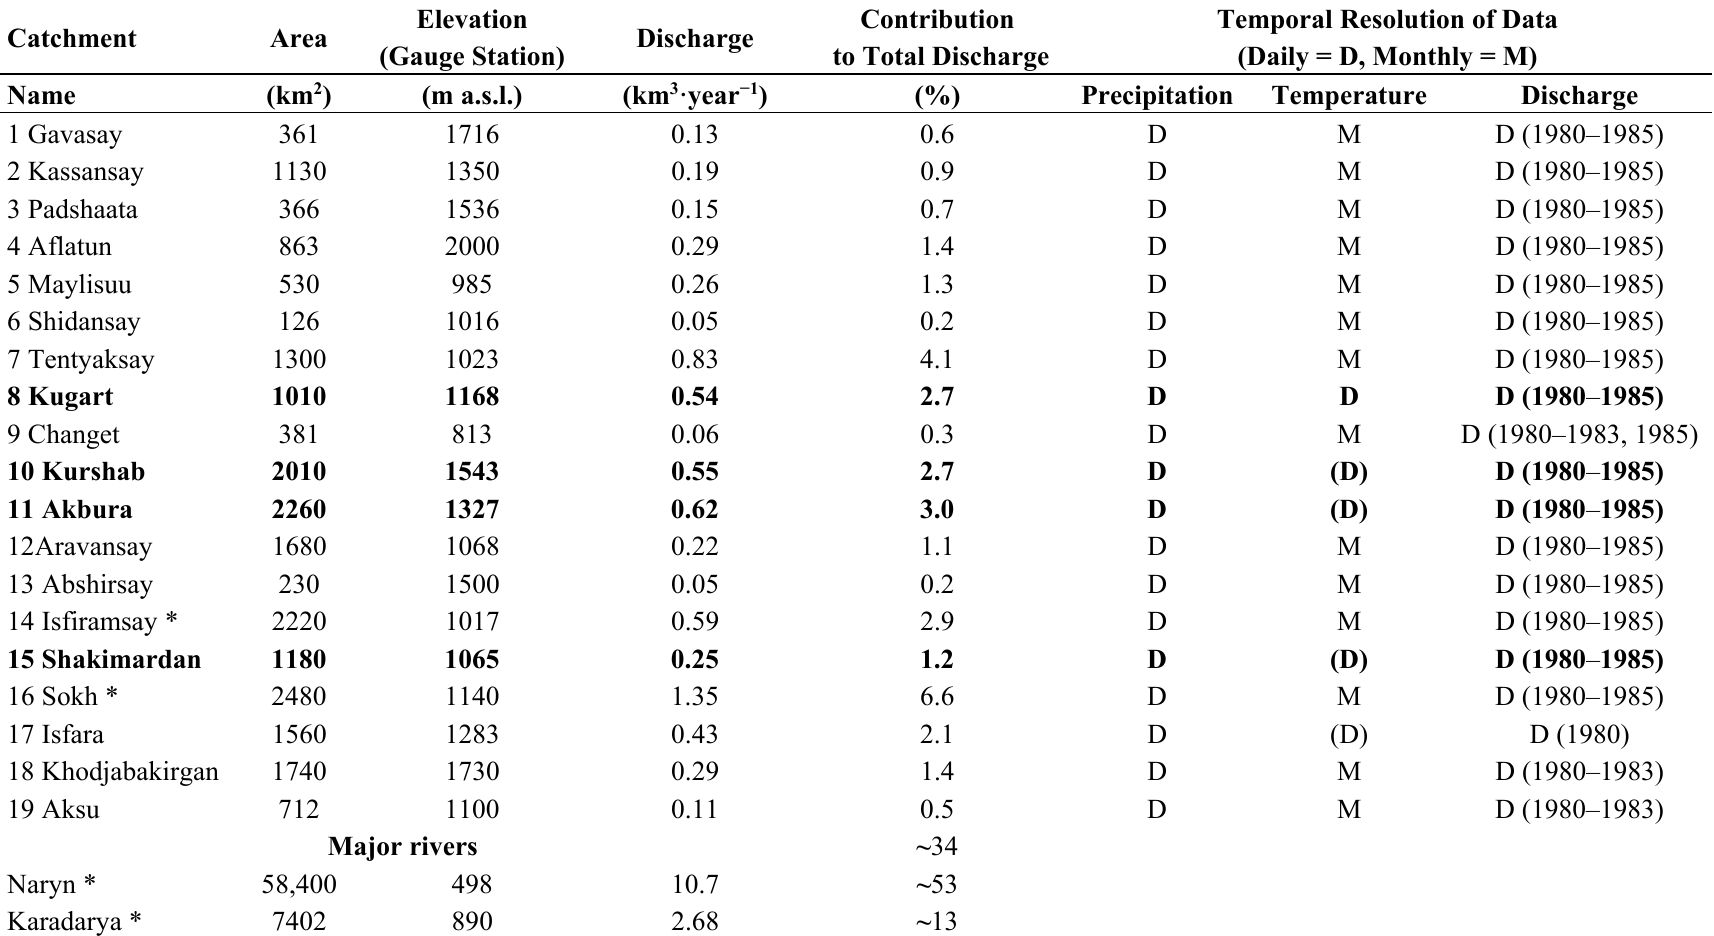
Table 1. Comparison of discharge data (km 3 ·year − 1 ) of the 19 upper sub-catchments flowing into the Syrdarya in relation to the inflows from the Naryn and Karadarya rivers (Data compiled from [20], obtained from the Central-Asian Institute of Applied Geosciences (CAIAG), Kyrgyz-Russian Slavic University (KRSU), and the Global Runoff Data Center (GRDC)* [21], retrieved 19.04.2011, (D)—data with